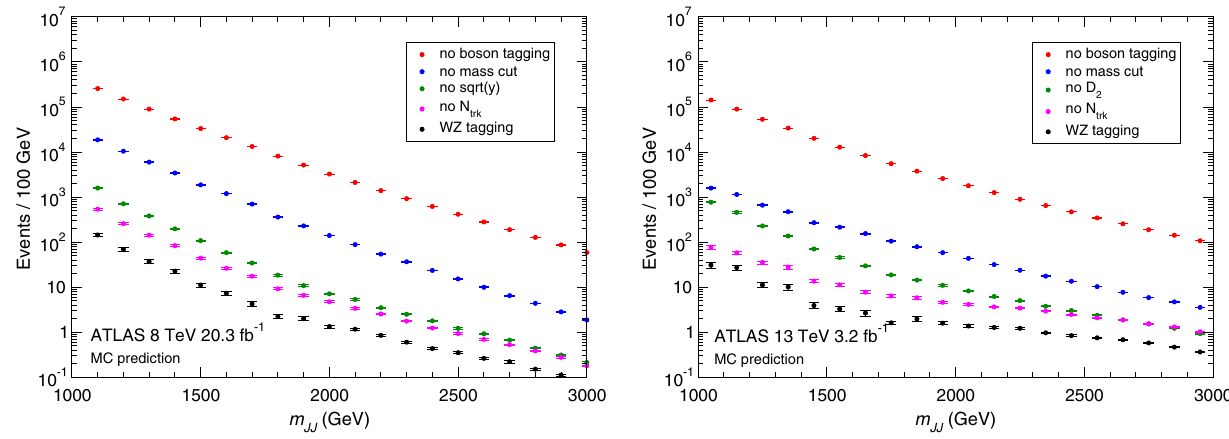
Fig. 1 MonteCarlopredictionsfortheQCDdijetbackground,withthe event selections for the ATLAS Run 1 (left) and Run 2 (right) hadronic diboson searches, from Ref. [4]. The black lines correspond to the full W Z boson tagging criteria described in Refs. [1,3]: jet mass cuts, (at Run 1) or D 2 (at Run 2) substructure tagging, and number of tracks